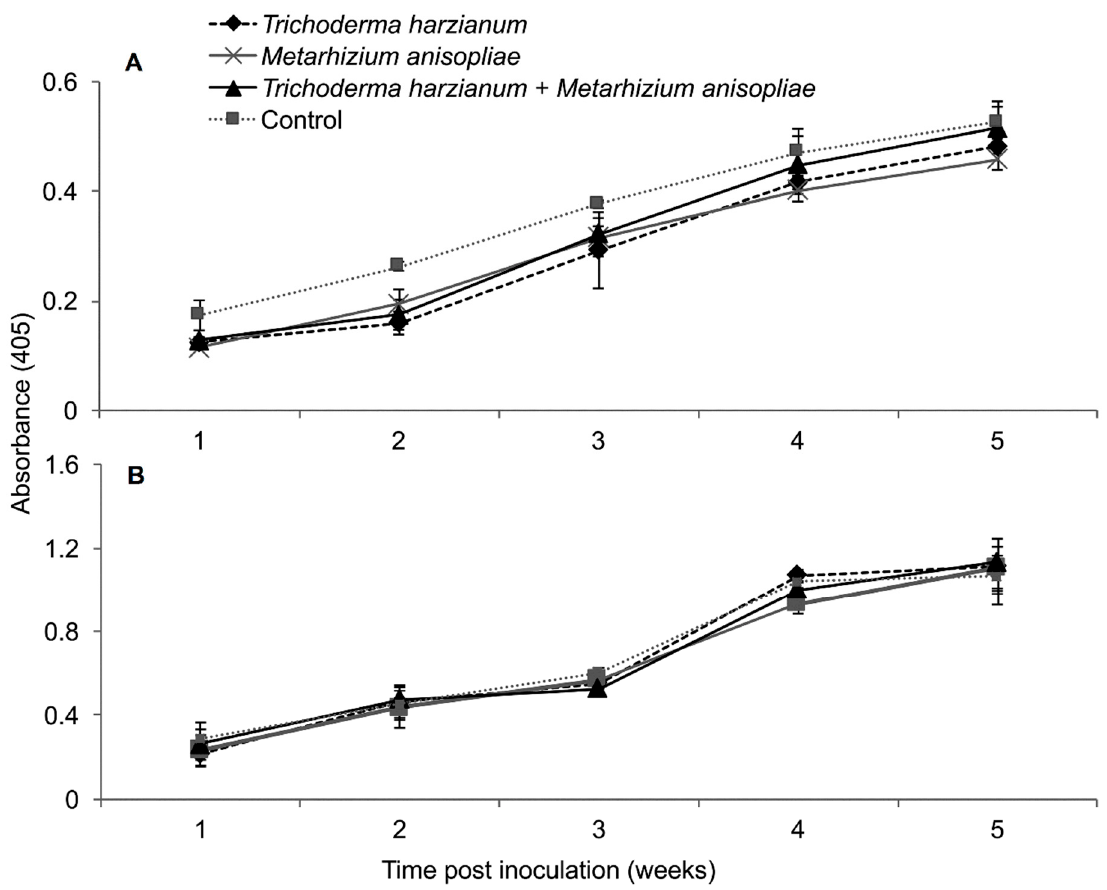
Figure 14. Titer levels of Sugarcane mosaic virus ( A ) and Maize chlorotic mottle virus ( B ) estimated over time through ELISA influenced by different treatments over time in dually infected plants—Second Trial.